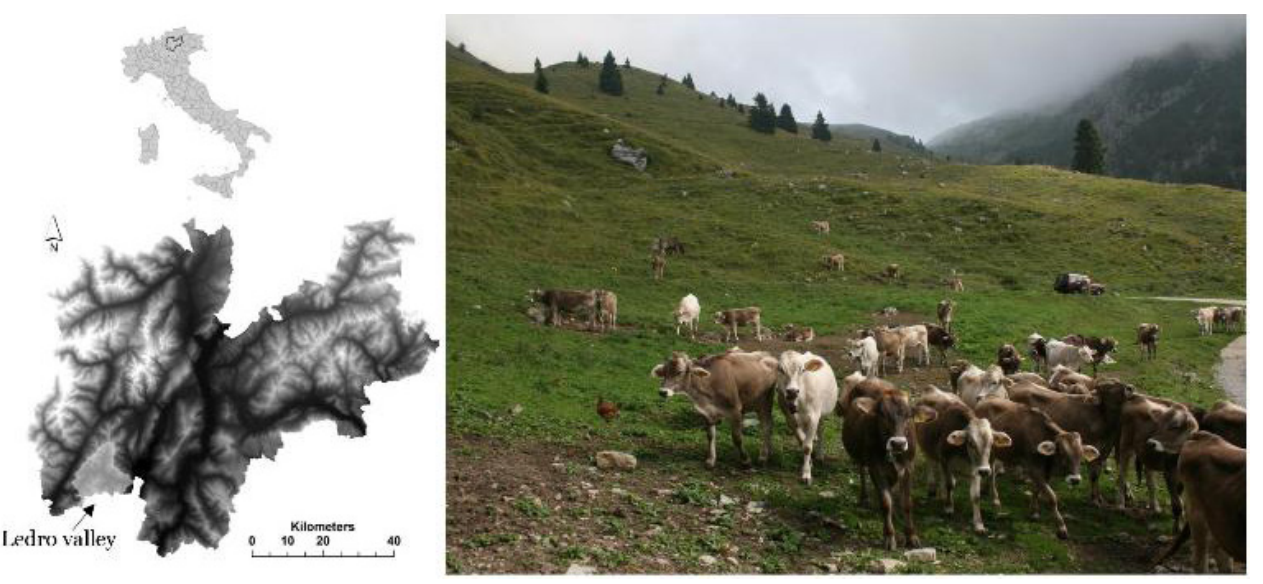
Fig. 1 . Ledro valley, northern Italy, and a characteristic